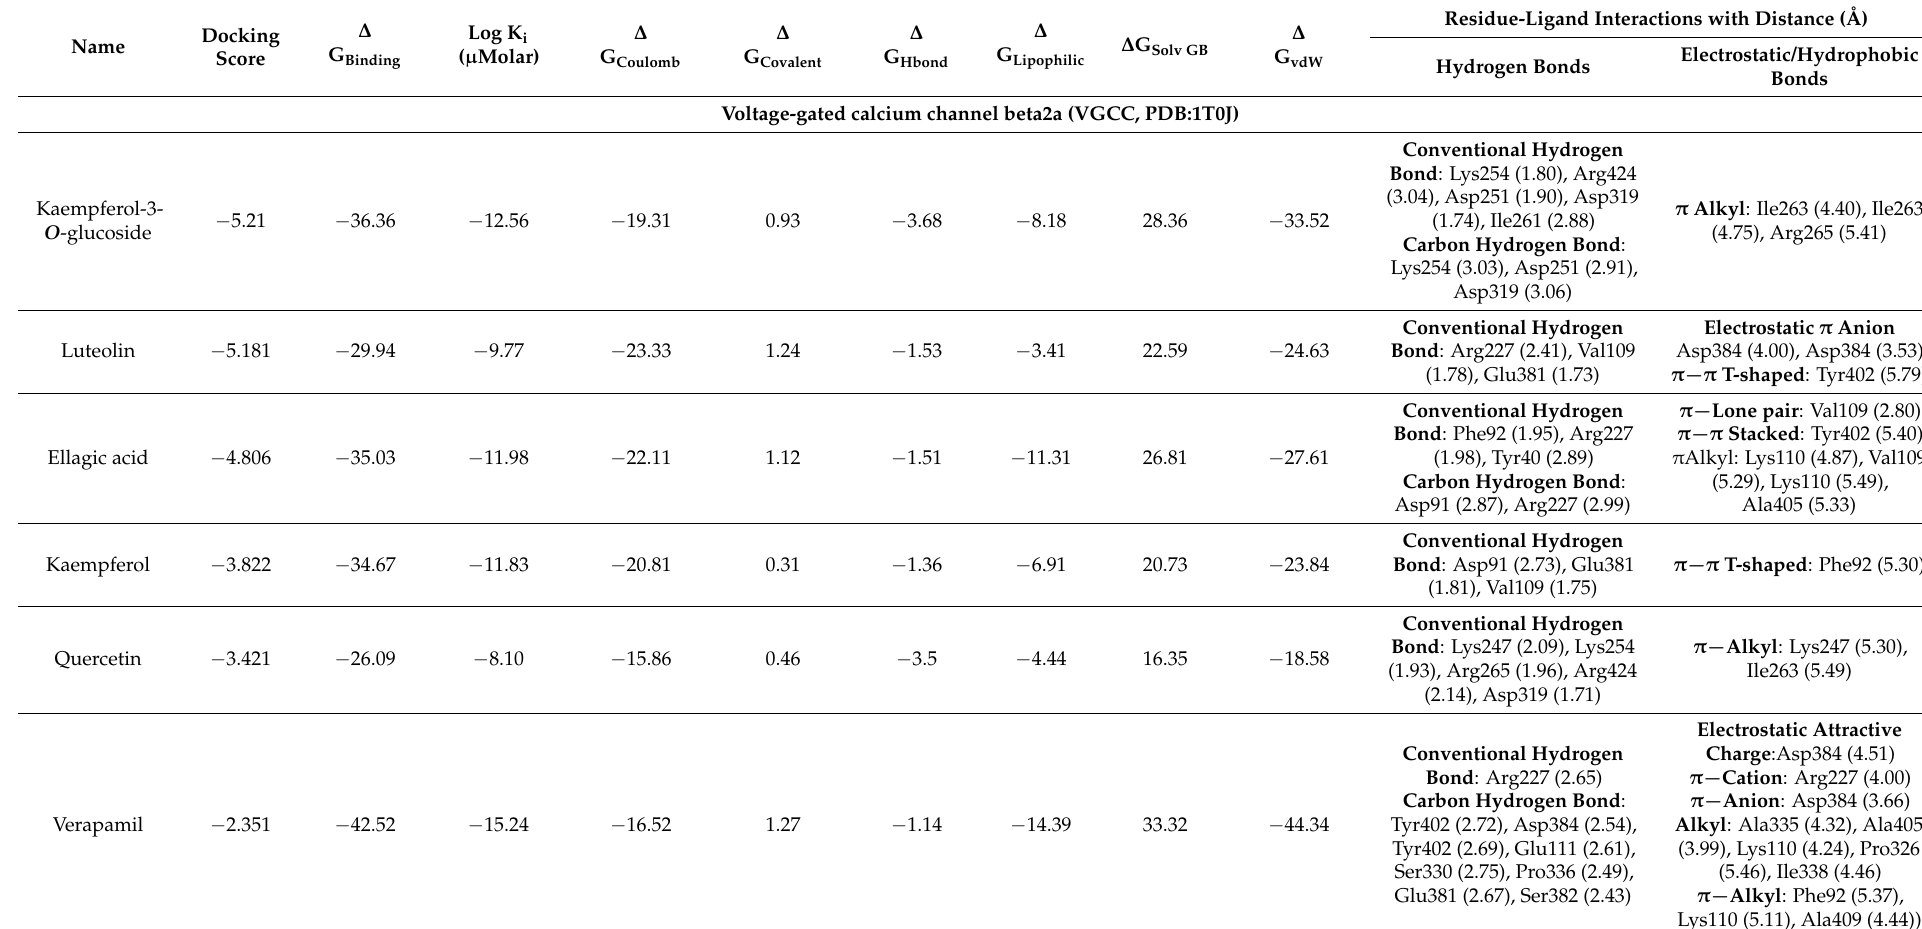
Table 4. Binding energies (kcal/mol) of compounds with voltage-gated calcium channel beta2a, calcium/calmodulin-dependent protein kinase IIB, Myosin light chain kinase-1,